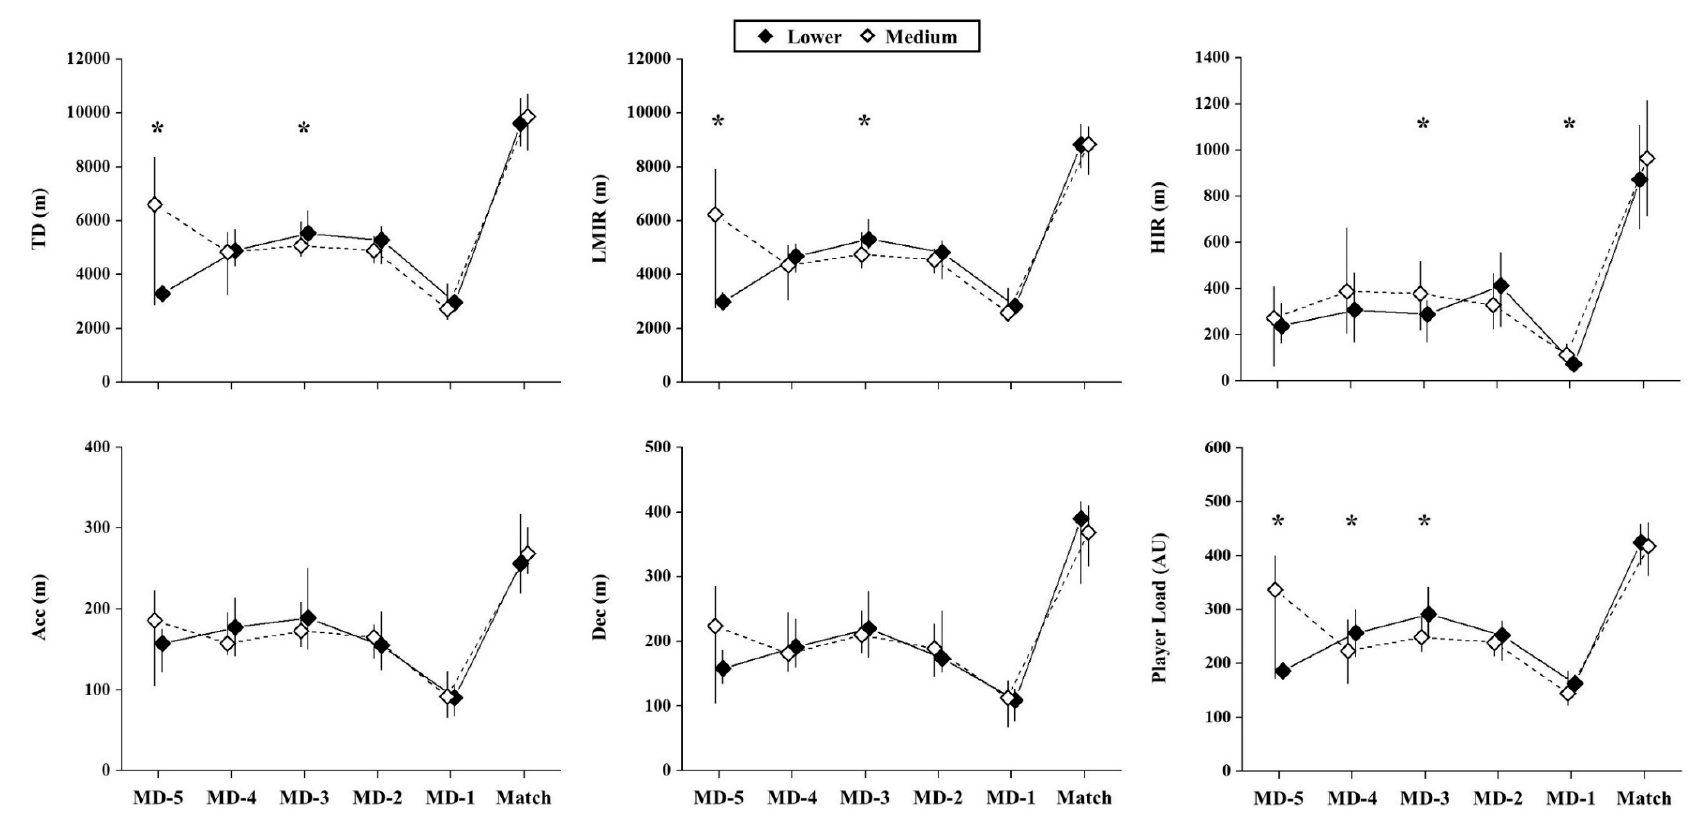
Figure 3. E ff ects of opponent standard on weekly external load parameters. TD: total distance covered; LMIR: total distance covered under low- to moderate-intensity running ( ≤ 18 m · h − 1 , m); HIR: total distance covered under high-intensity running ( > 18 km · h − 1 ); Acc: total distance covered under high-intensity acceleration ( ≥ 2 m · s − 2 ); Dec: total distance covered under high-intensity deceleration ( ≤− 2 m · s − 2 ); MD-5 = five days before the match; MD-4 = four days before the match; MD-3 = three days before the match; MD-2 = two days before the match; MD-1 = one day before the match. *: Significant di ff erences between days before playing against bottom vs. medium-ranking teams ( p < 0.05).